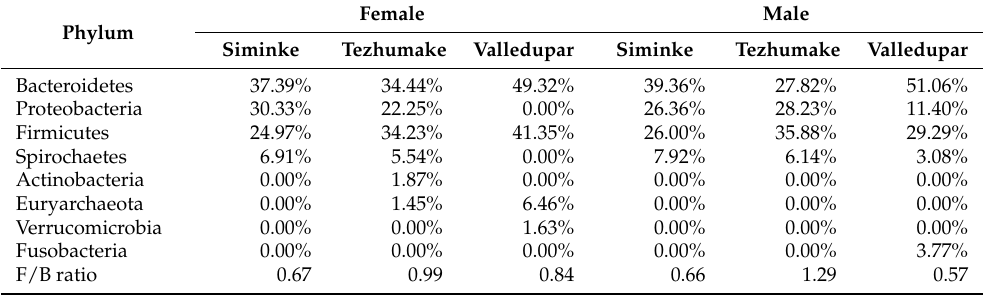
Table A4. Phylum distribution for the gender groups in the three locations. Data indicate relative abundances (percentages of OTU counts). Phyla with relative abundances lower than 1% were filtered